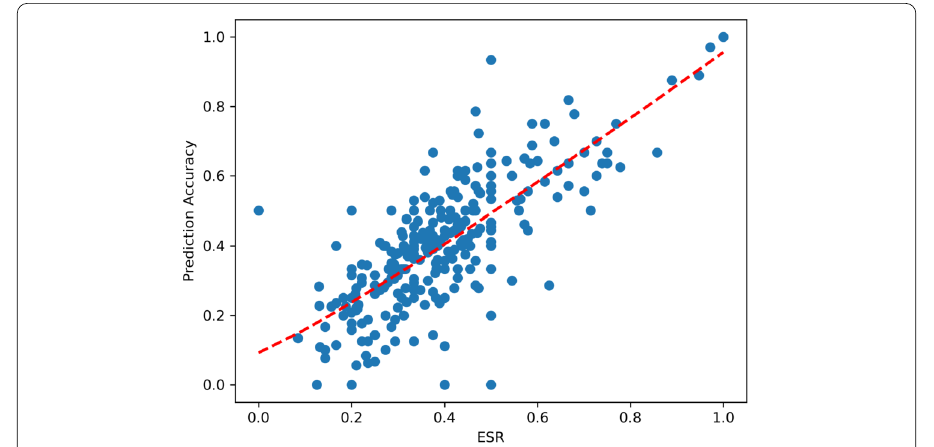
Table 9 An average proportion of predictability variations explained by the regression models fit to the evaluated metrics calculated for the two types of mobility sequences